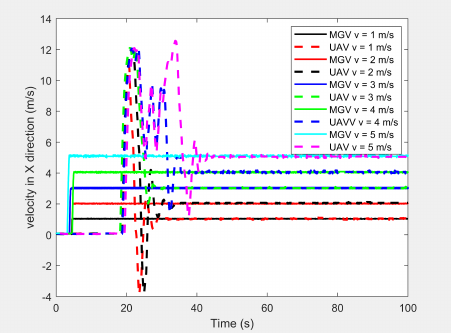
Figure 9. The UAV’s horizontal velocity for different constant velocities of the